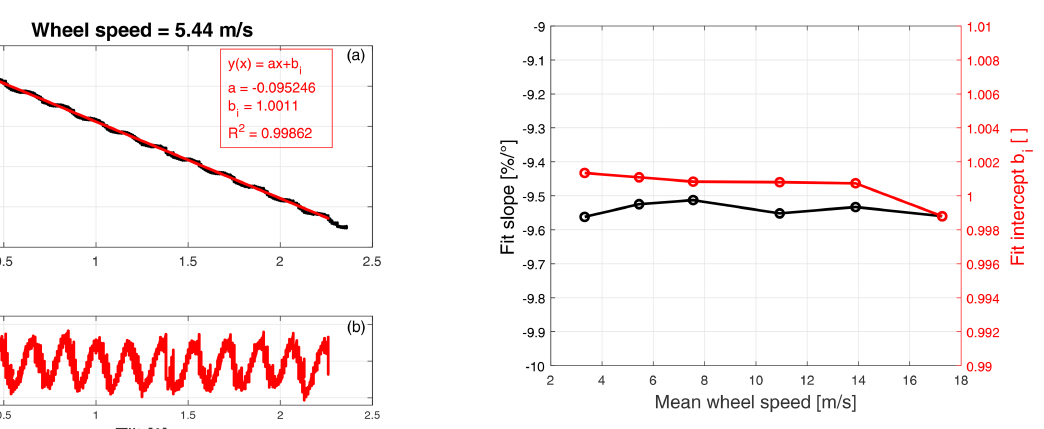
Figure 15. Results of fits for different reference speeds. Fit intercept is not compensated for w .